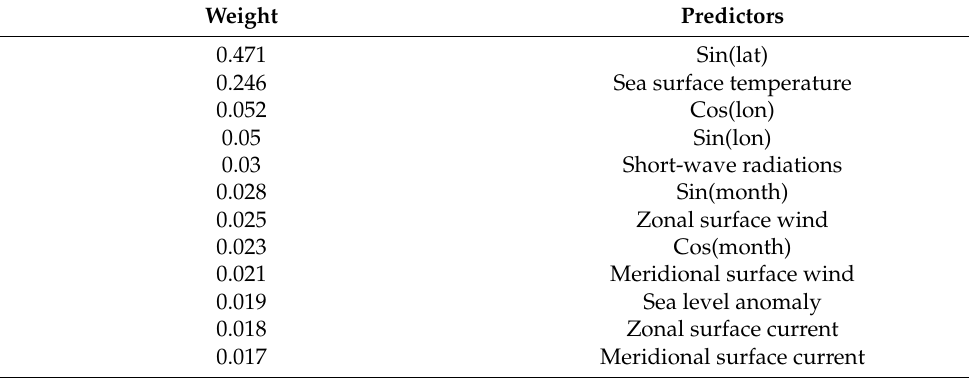
Table 2 has been corrected as follows: Table 2. Multi-layer perceptron (MLP) predictor’s relative